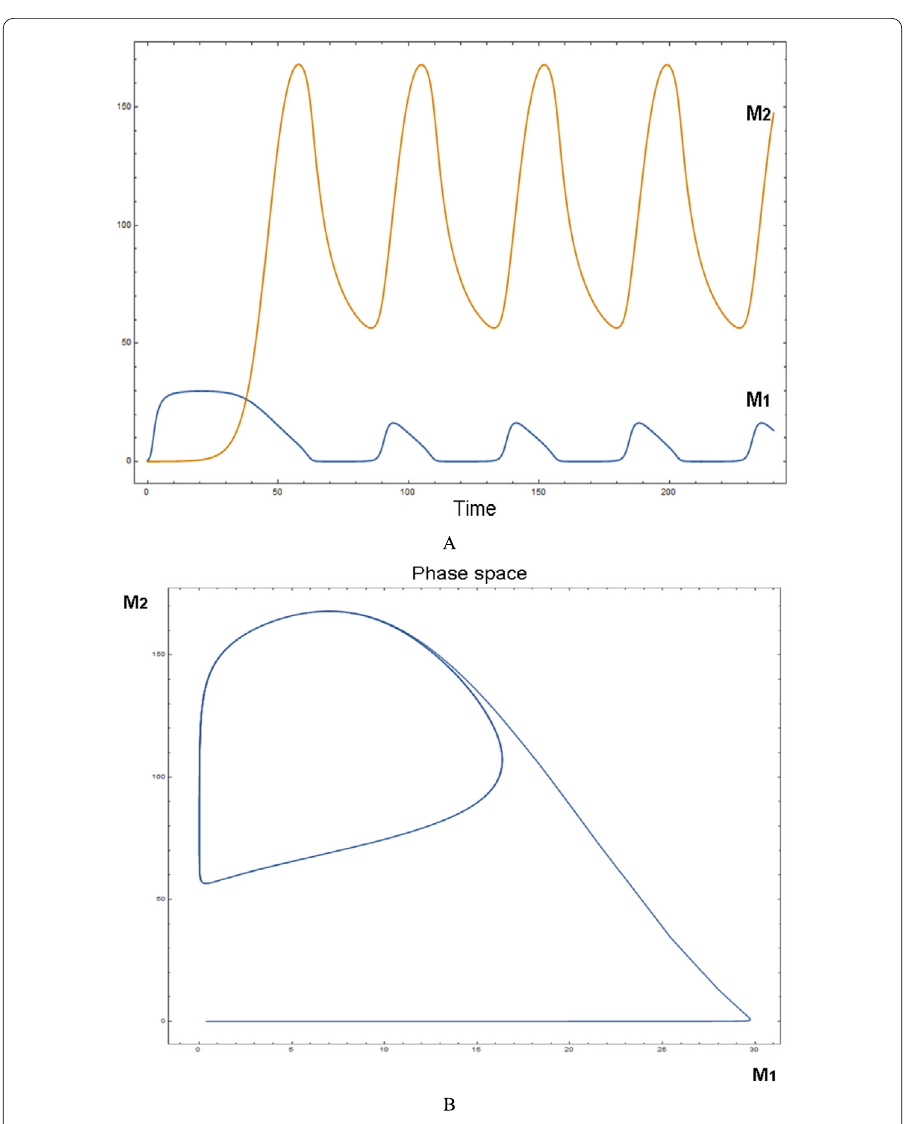
Figure 4 Time series showing the existence of periodic solutions at the steady state equilibrium neighborhood A and the phase portrait in B for M 1 (0) = 0.39, M 2 (0) = 0.01, a 1 = 0.06, b 1 = 0.039, V = 30, a 2 = 0.023, b 2 = 0.06, a 3 = 0.3, n = 0.9, m =